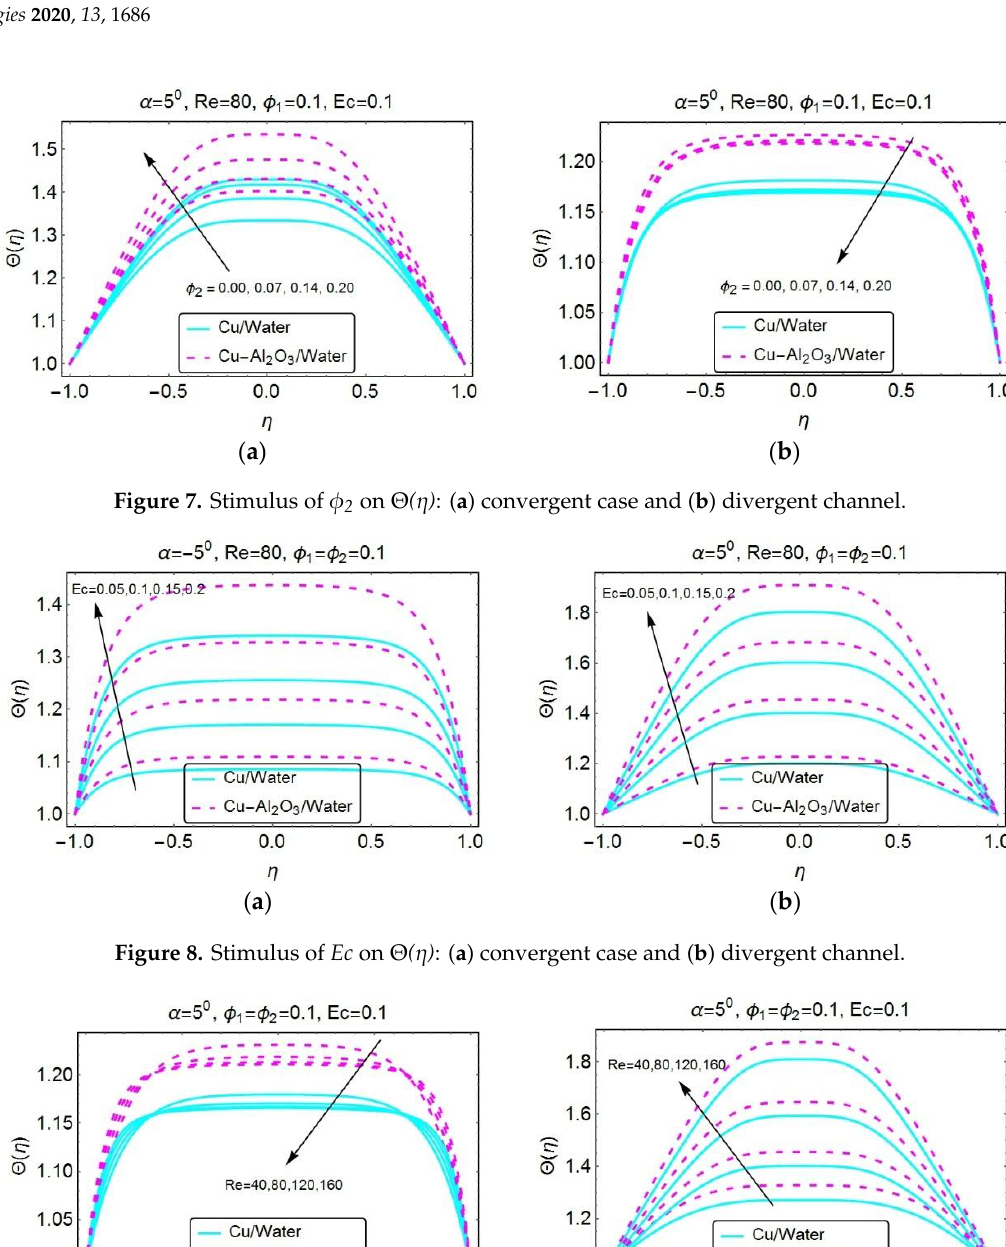
Figure 6. Stimulus of α on Θ(η) : ( a ) convergent case and ( b ) divergent channel.